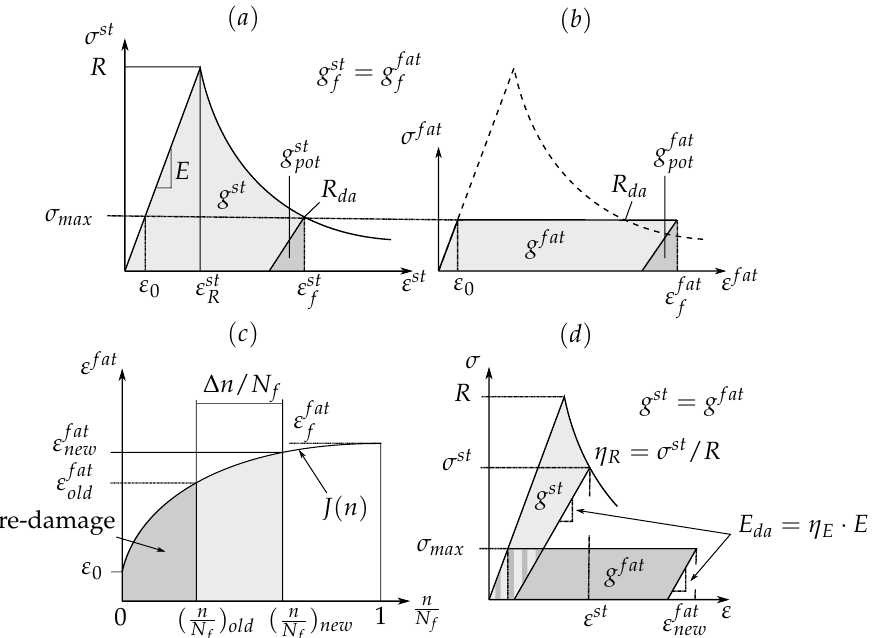
Figure 11. Schematic illustration of the determination of the stiffness ( η E ) and strength ( η R ) degradation factors: ( a ) static stress-strain curve; ( b ) virtual cyclic stress-strain curve; ( c ) strain/damage evolution depending on normalized load cycles; ( d ) determination of the degradation factors η E and η R , see